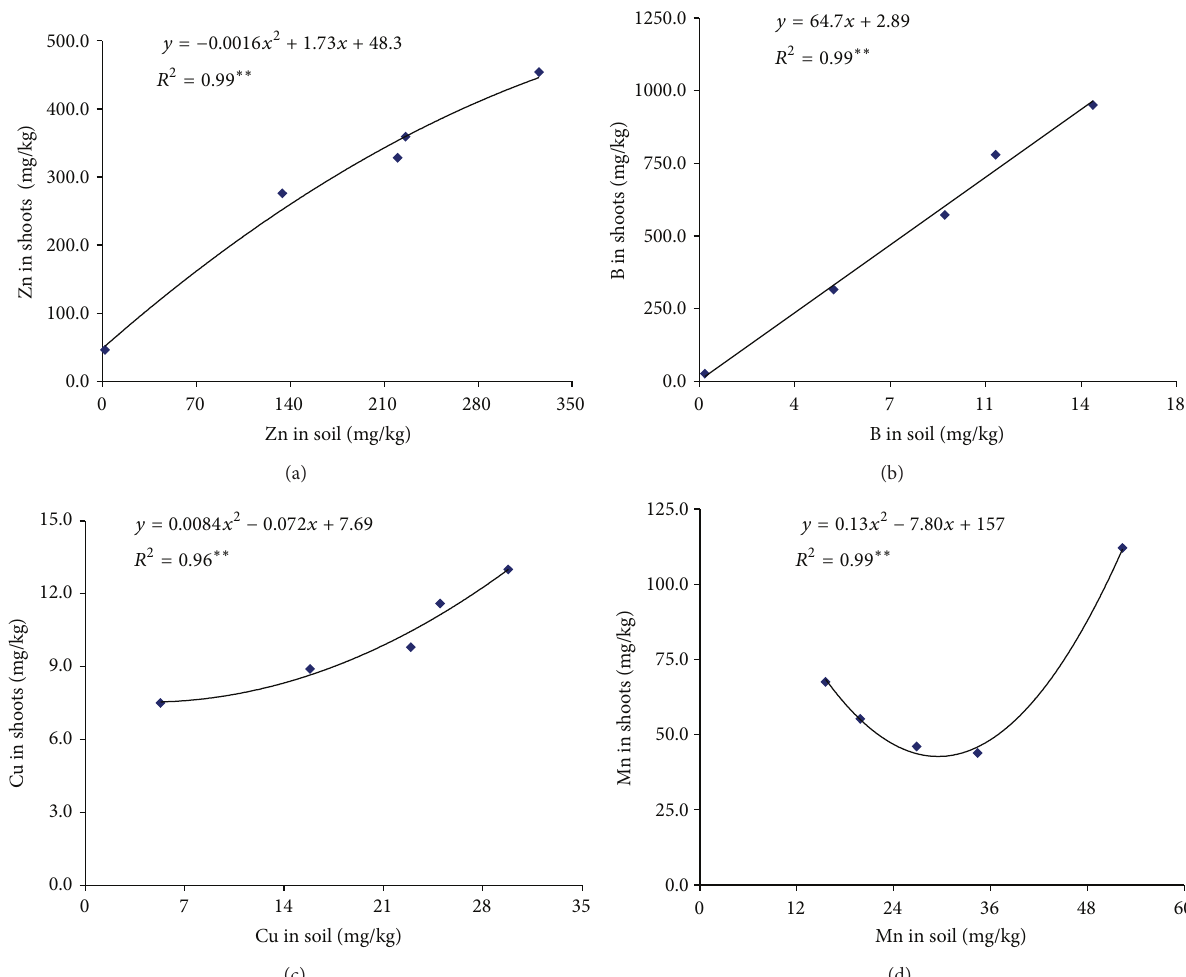
Figure 2: Corn shoots uptake and available content of elements in soil. ∗∗ Significant at 𝑃 < 0.01